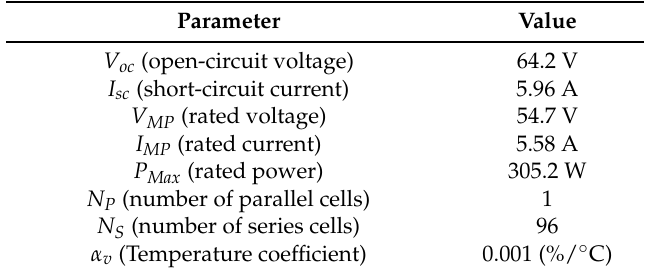
Table 1. Parameters of the SunPower SPR-305NE-WHT-D 305W module under STC.